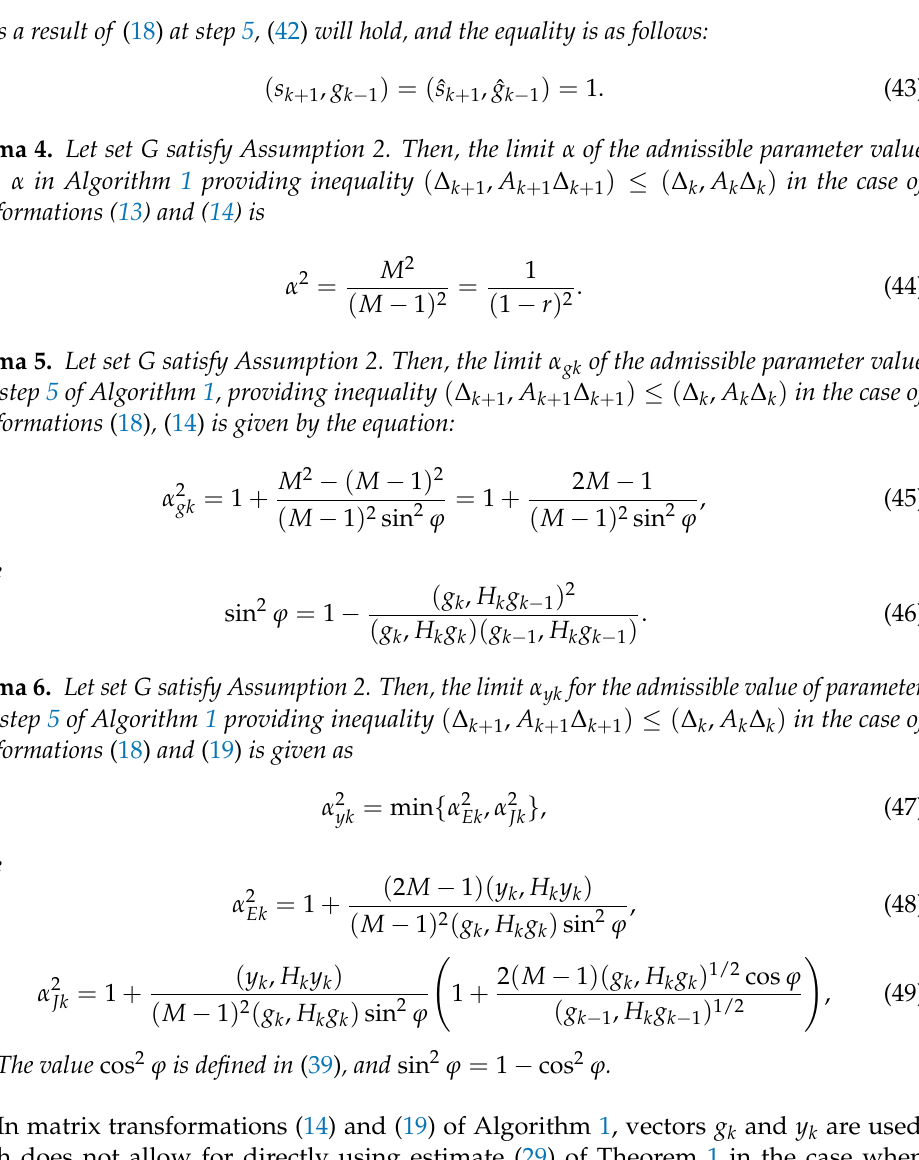
Algorithm 1 for fixed values of the space dilation parameters α 2 where parameter α is specified according to (44) .